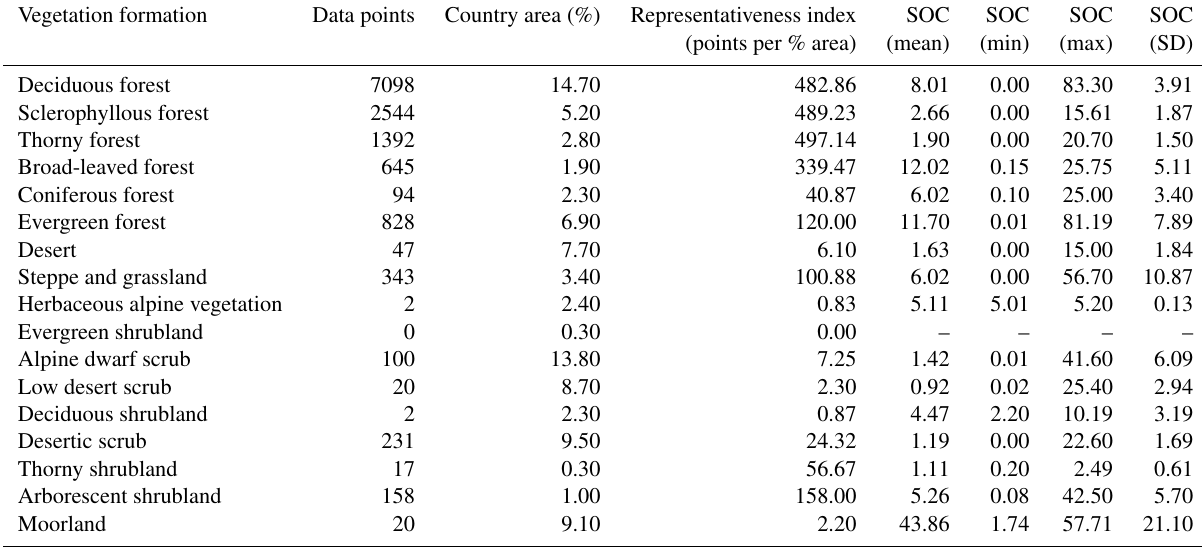
Table 3. Distribution of SOC data points per ecosystem (vegetation formation) according to Luebert and Pliscoff (2006). Vegetation